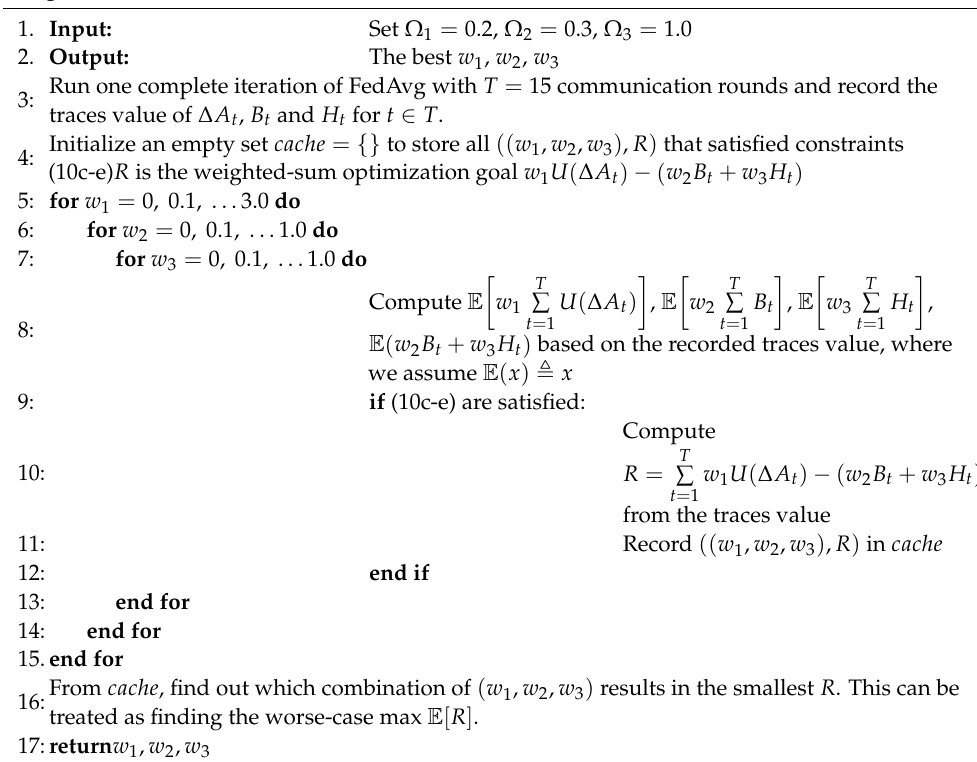
Algorithm 1 Search for the best w 1 , w 2 and w